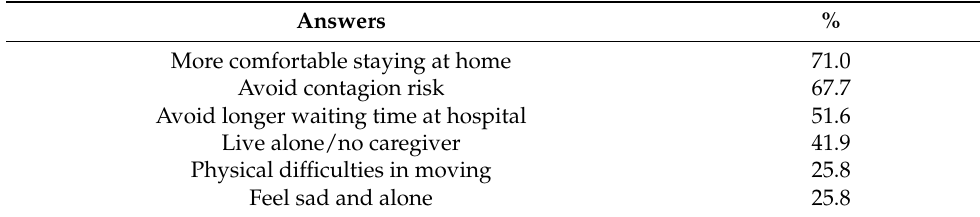
Table 4. Home care service customer satisfaction. How did home care service help you?